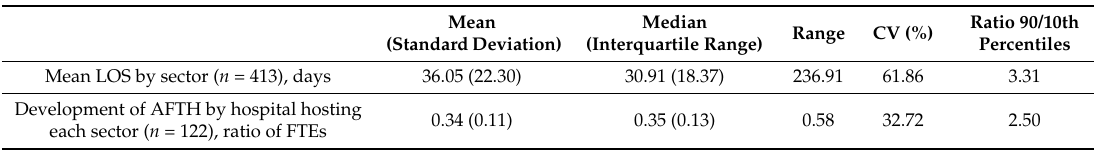
Mean Median Ratio 90/10th Range CV (%) (StandardDeviation) (Interquartile Range) Percentiles